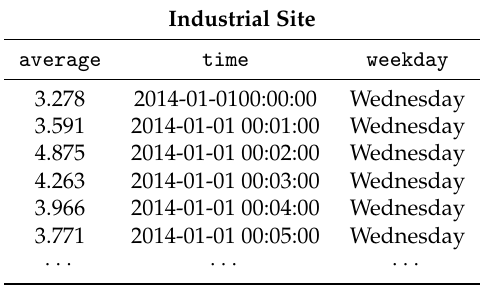
Table 2. Structure of the preprocessed data from the industrial site (first six